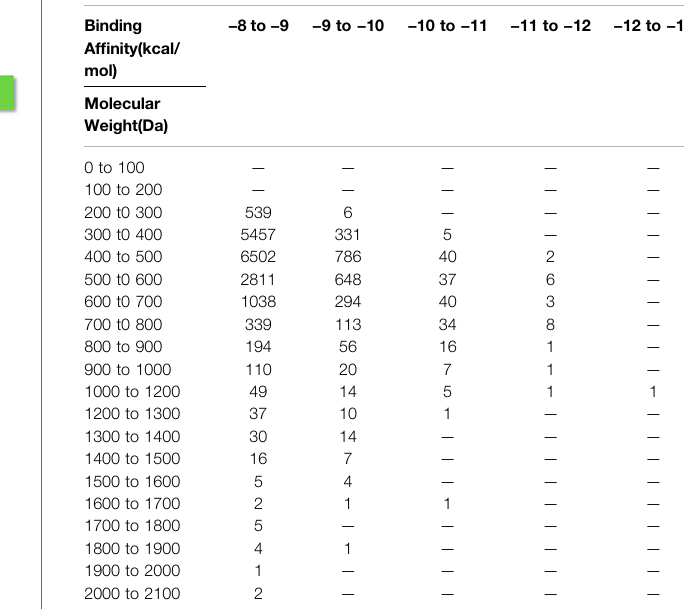
TABLE 1 | Binding energy vs . molecular weight of virtual screening